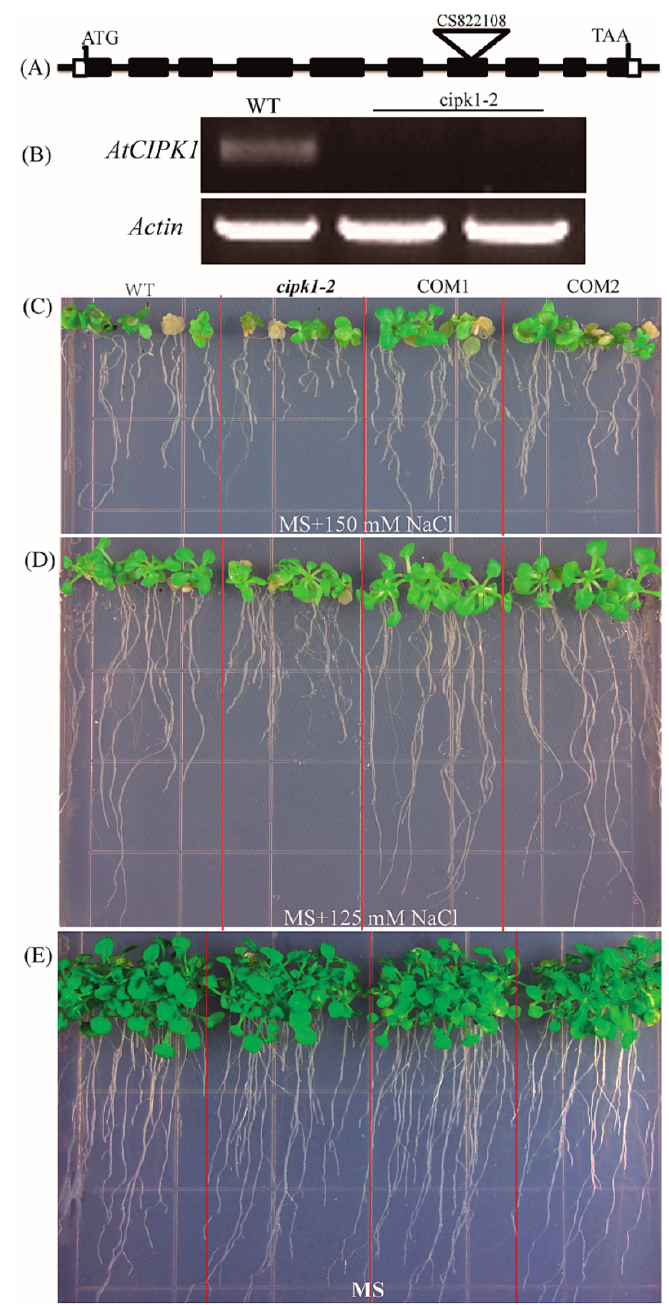
Figure 5. The salt-sensitive phenotype of Arabidopsis cipk1-2 was complemented by over-expressing of ZmCIPK21. ( A ) Intron-exon structure of the Arabidopsis CIPK1 gene and location of the T-DNA insertion; ( B ) Transcript levels of CIPK1 in the Arabidopsis cipk1-2 mutant; ( C – E ) Phenotypes of wild-type, cipk1-2 , and ZmCIPK21 in cipk1-2 (COM) lines grown on MS agar plates containing different concentrations of NaCl (0, 125, or 150